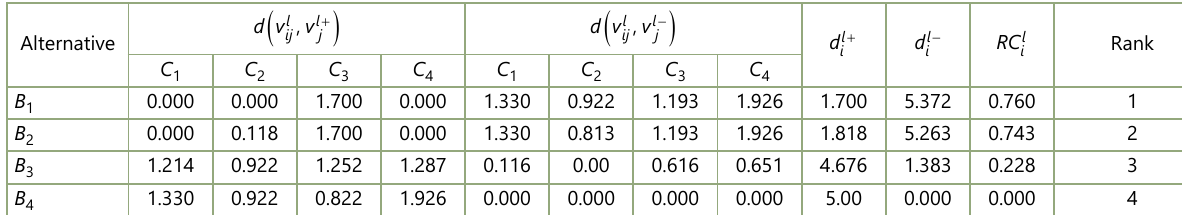
Table 20. The distances from the ideal and anti-ideal solutions with calculated rank indicator for food ( l = 3) (source: own contribution)